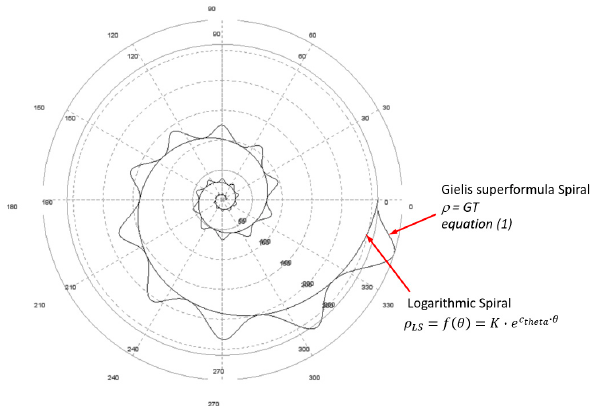
Figure A1. Overlapping of Logarithmic and Gielis superformula spirals with parameters reported in Table 1.